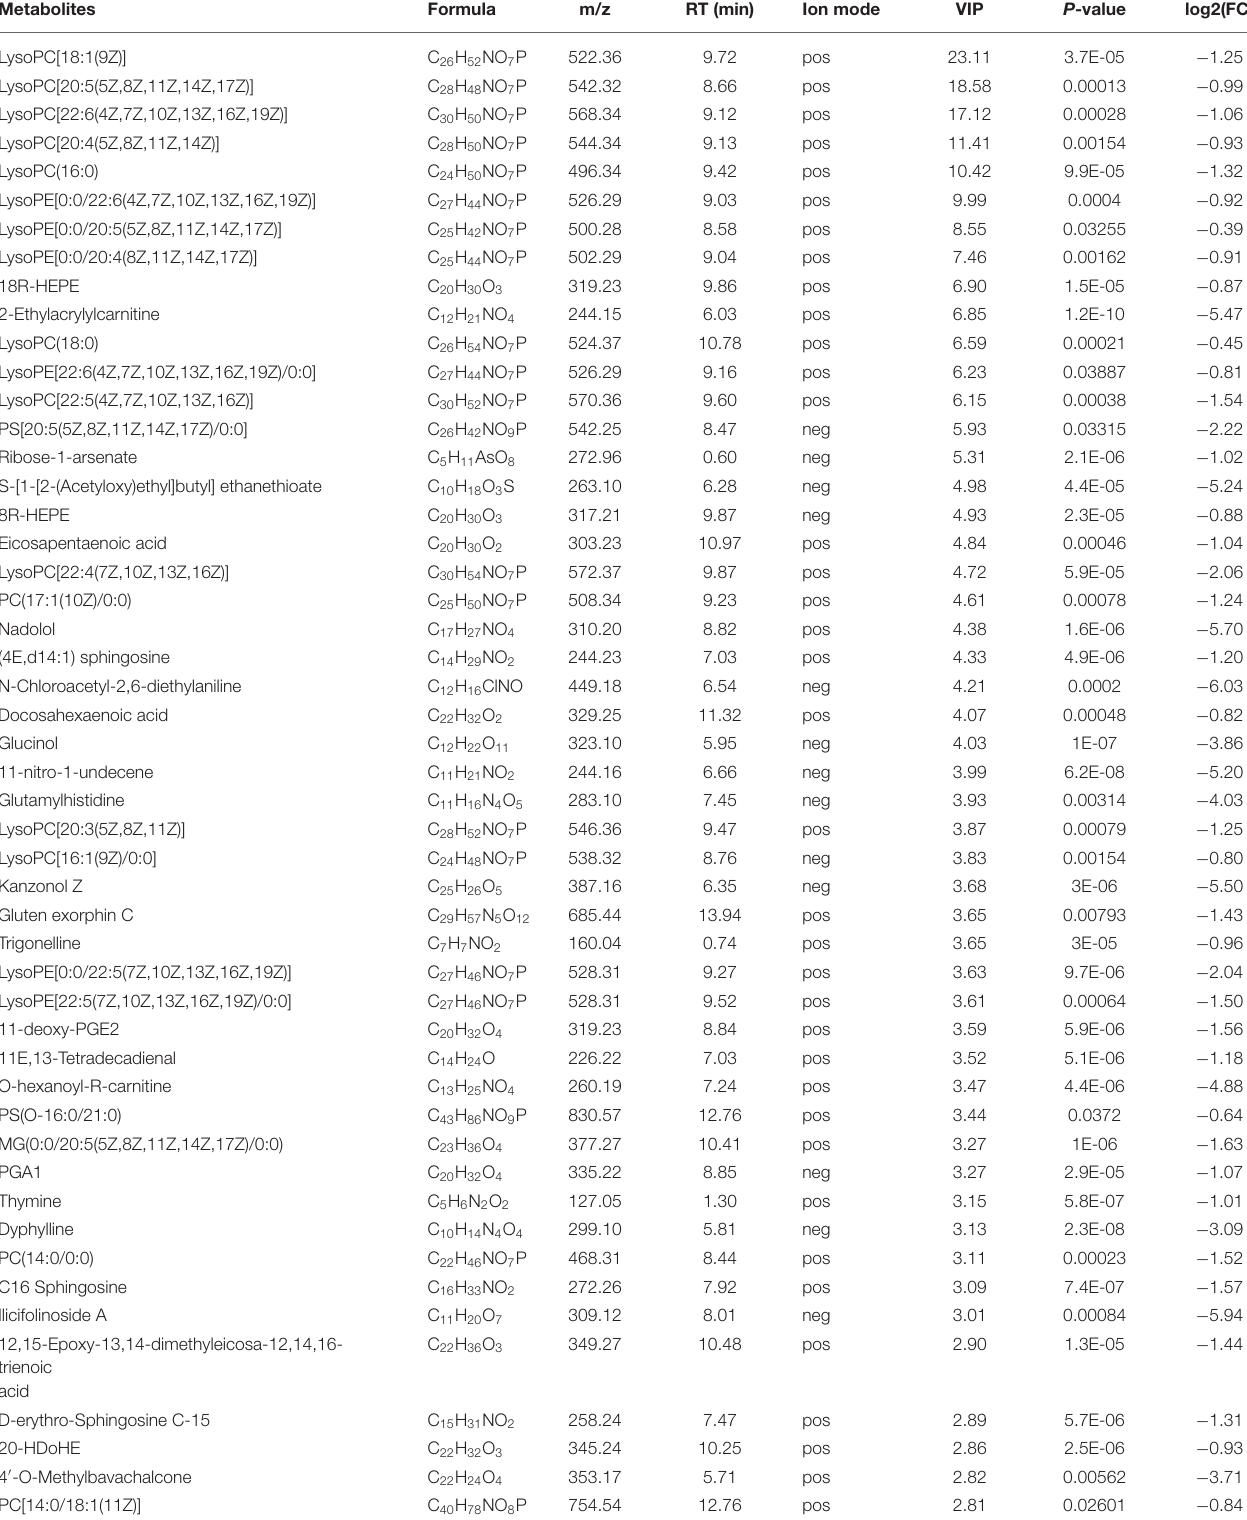
TABLE 2 | Down-regulated metabolites in gills of Scylla paramamosain response to sudden drop in salinity from 23 to 3psu. Metabolites